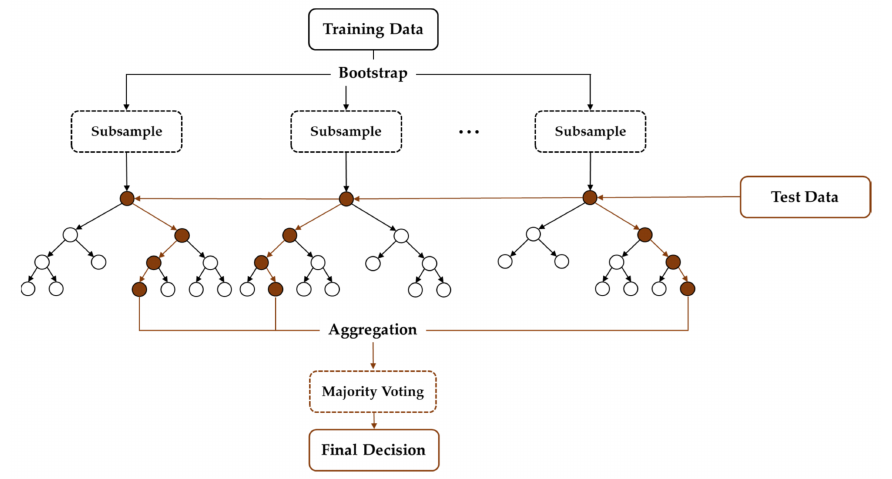
Figure 4. The structure of random forest (RF). RF is one of the bagging (bootstrap aggregating) methods that adopts bootstrapping and aggregation. In bootstrapping, RF generates multiple decision trees (DTs) using random subsets with the replacement of training data. In aggregation, RF labels the test data based on the class elected by majority voting from multiple